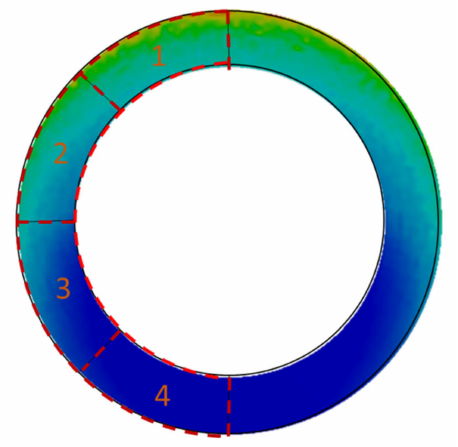
Figure 19. Characteristic zones on the gasket’s surface for calculating the average contact